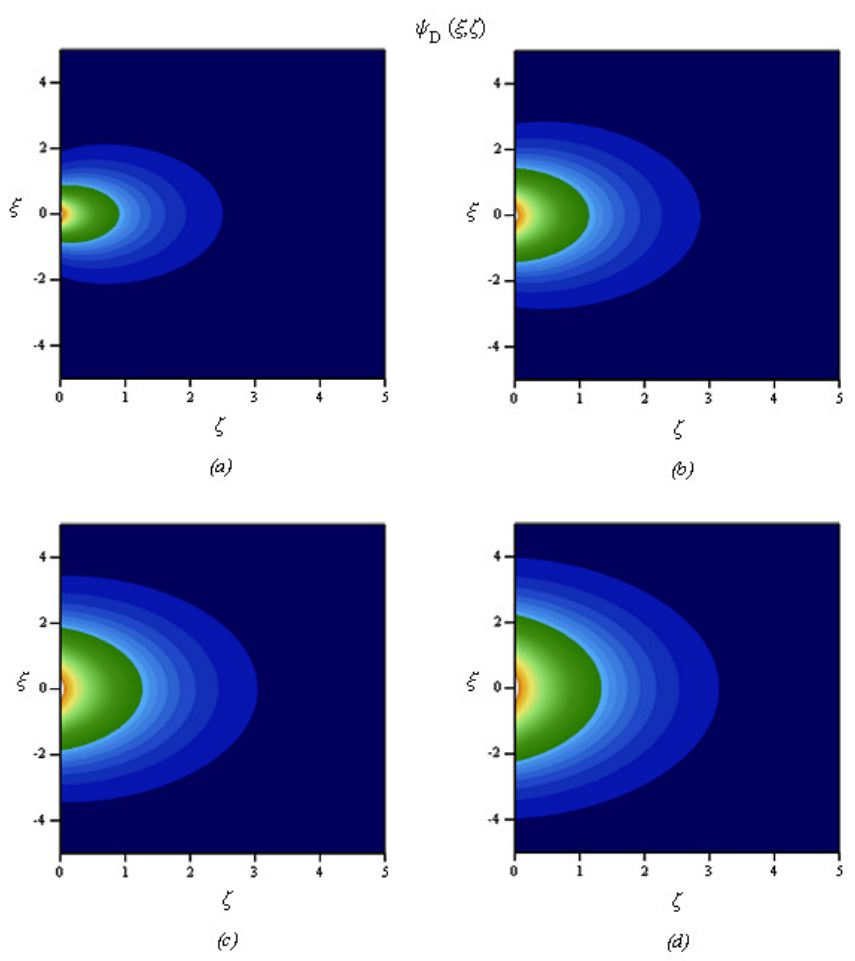
Figure 6. ( ζ , ξ ) -contourplots exemplifyng the ζ -evolution of the fundamental solution of ( ξ , ζ ) , for ( a ) ε = 0 . 5 , ( b ) ε = 1 , ( c ) ε = 1 . 5 , and ( d ) ε = 2 Equation (79), i.e. , ψ D